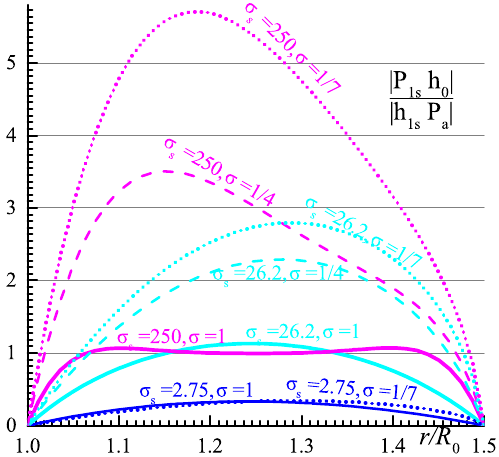
Figure 14. Distribution of P 1s inside of the 1D parallel ring with high-pressure inside.